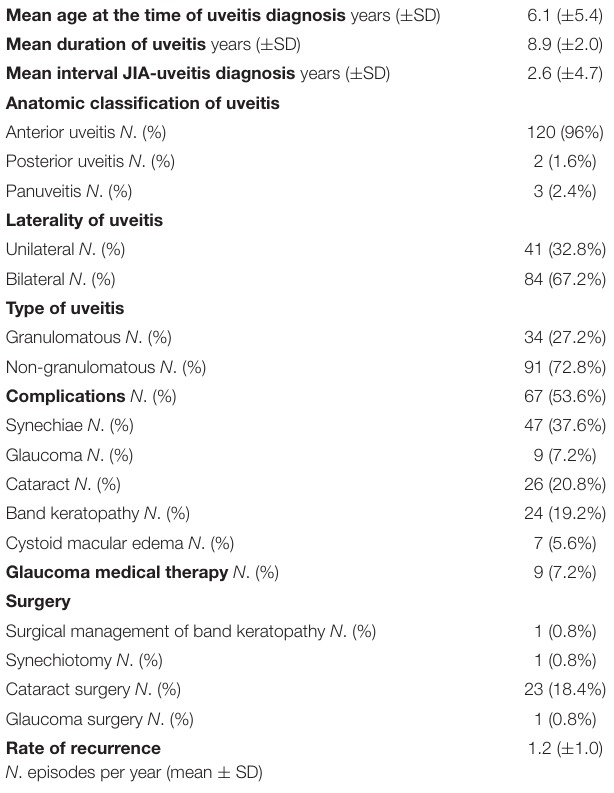
TABLE 1 | Demographic and clinical features of our sample of